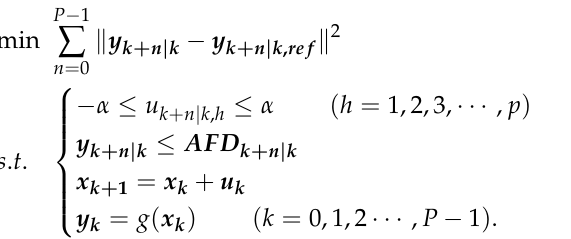
Figure 3. A schematic diagram of the aiming strategy with MPC